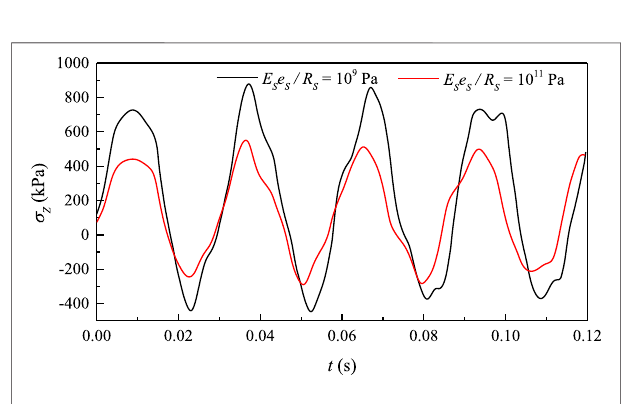
FIGURE 12 | Axial stress of pipe wall fl uctuates with E s e s /R s .